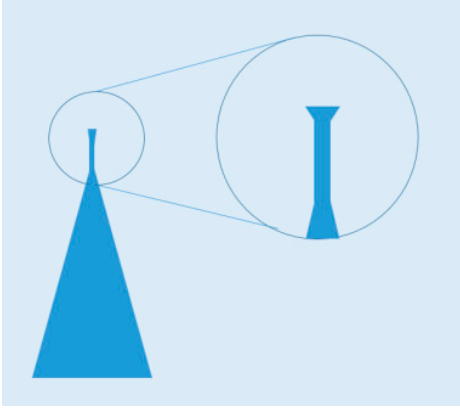
Figure 67. The shape of 3D AFM.